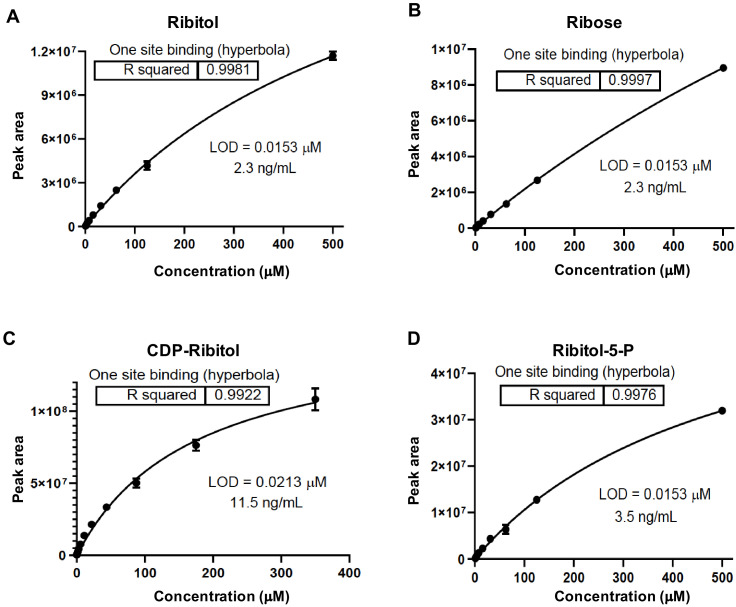
Liquid chromatography with tandem mass spectrometry (LC/MS-MS) standard curves.(A–D) Standard curves from serial dilution of metabolites (A) ribitol, (B) ribose, (C) ribitol-5-P, and (D) cytidine diphosphate (CDP)-ribitol.